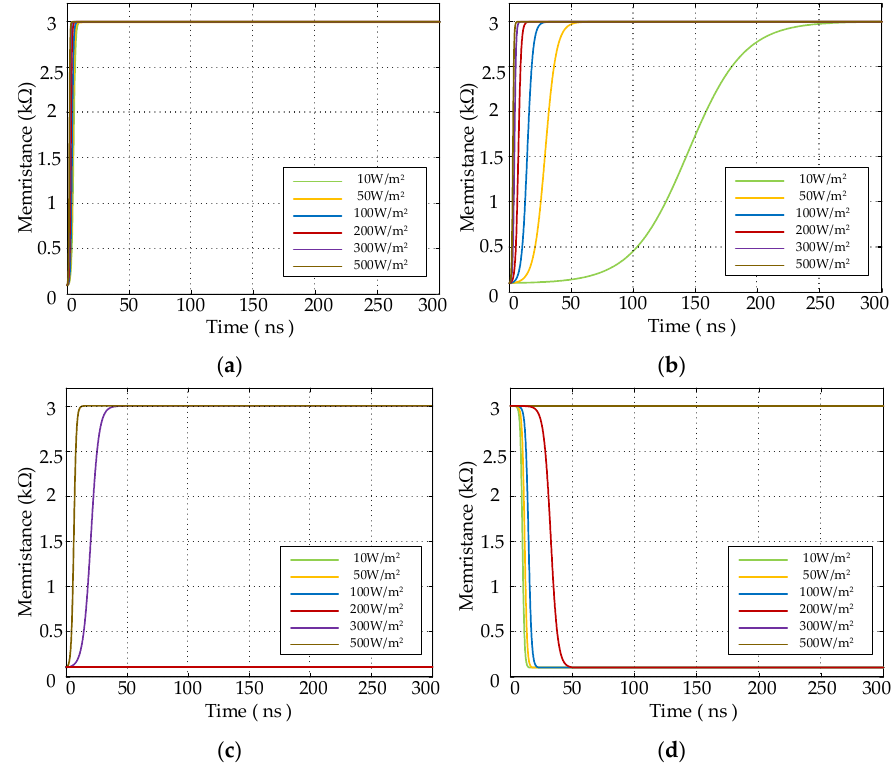
Figure 4. Simulation results at different optical power densities under constant voltages showing ( a – c ) M − t curves of the memristor with initial resistance R on at − 3 V, 0 V, 3 V; and ( d ) M − t curve of the memristor with initial resistance R off at 3 V.